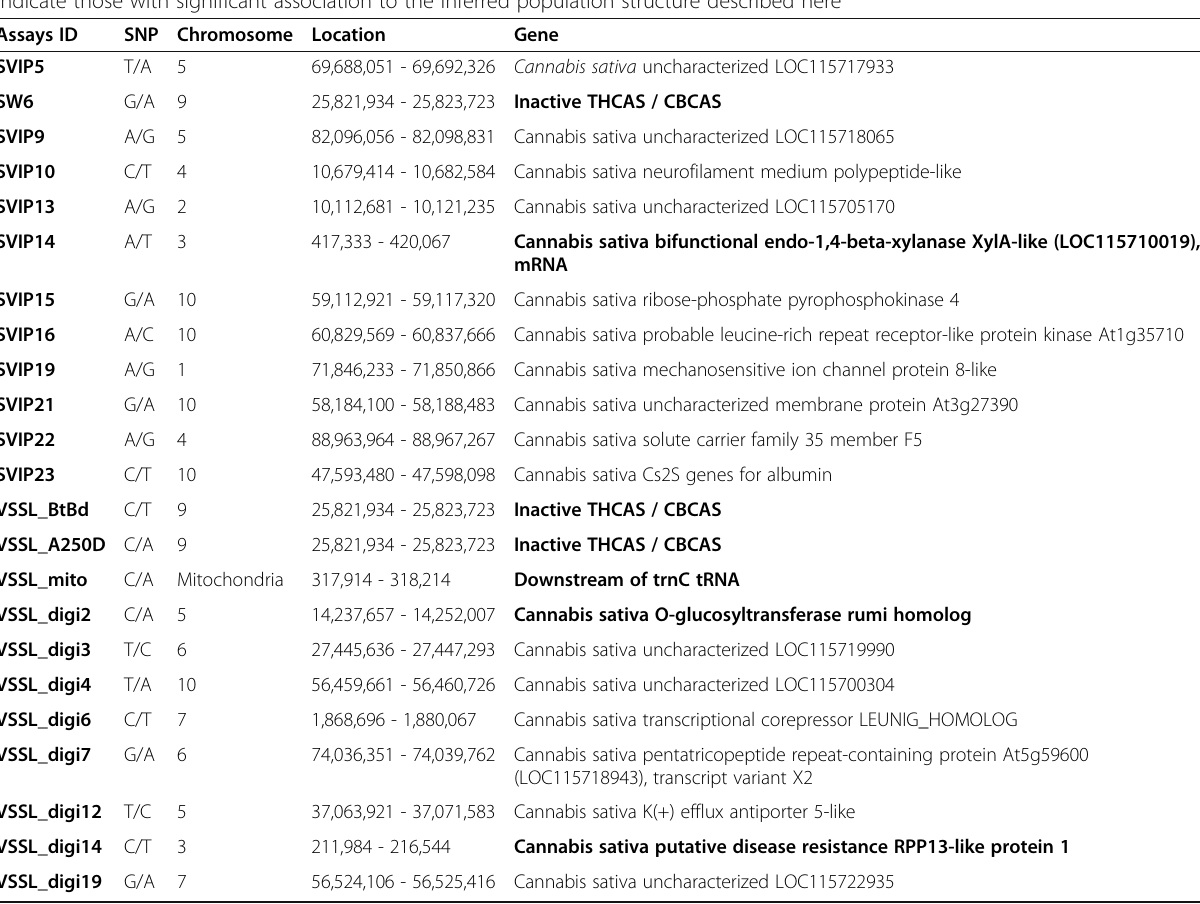
Table 2 Information about the 23 SNPs used in the study. Including genomic location and putative function. Bolded markers indicate those with significant association to the inferred population structure described here Assays